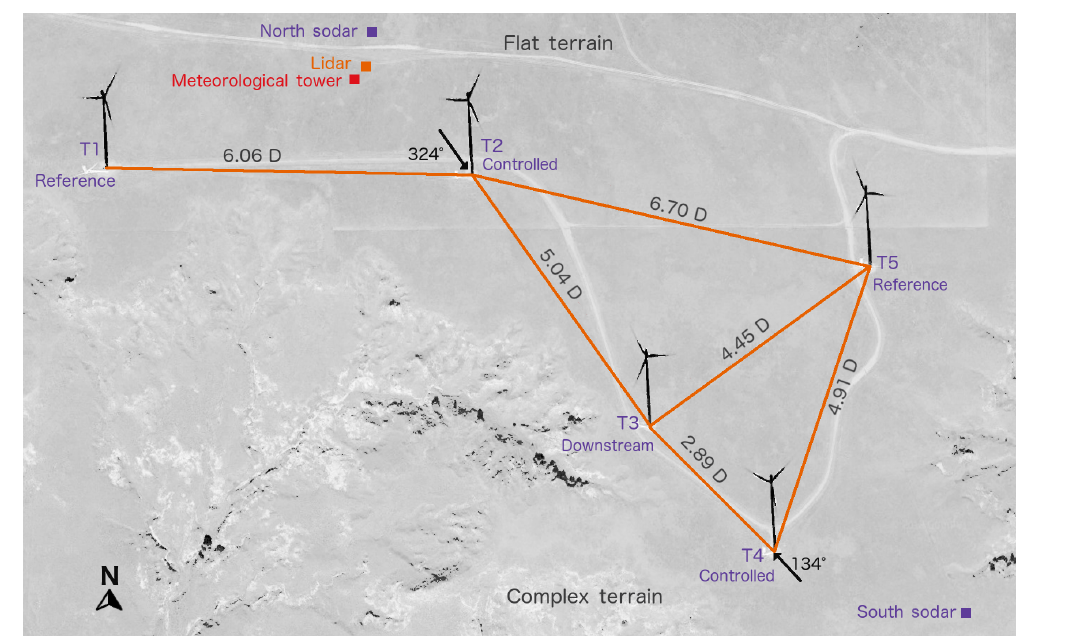
Figure 1. Layout of the experimental site. Turbine 2 (T2) and Turbine 4 (T4) have wake steering implemented to benefit Turbine 3 (T3), whereas Turbine 1 (T1) and Turbine 5 (T5) are reference turbines. The position of the installed meteorological equipment is also shown. Finally, the complexity of the terrain to the south and the flat terrain to the north are indicated.